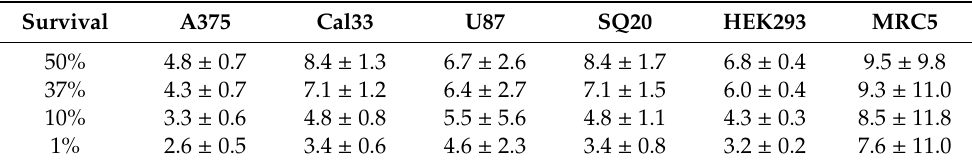
Table 3. Thermal neutron relative biological e ff ectiveness (RBE) values ( w t factor) for the di ff erent cell lines irradiated at ILL as a function of the cell survival fraction.